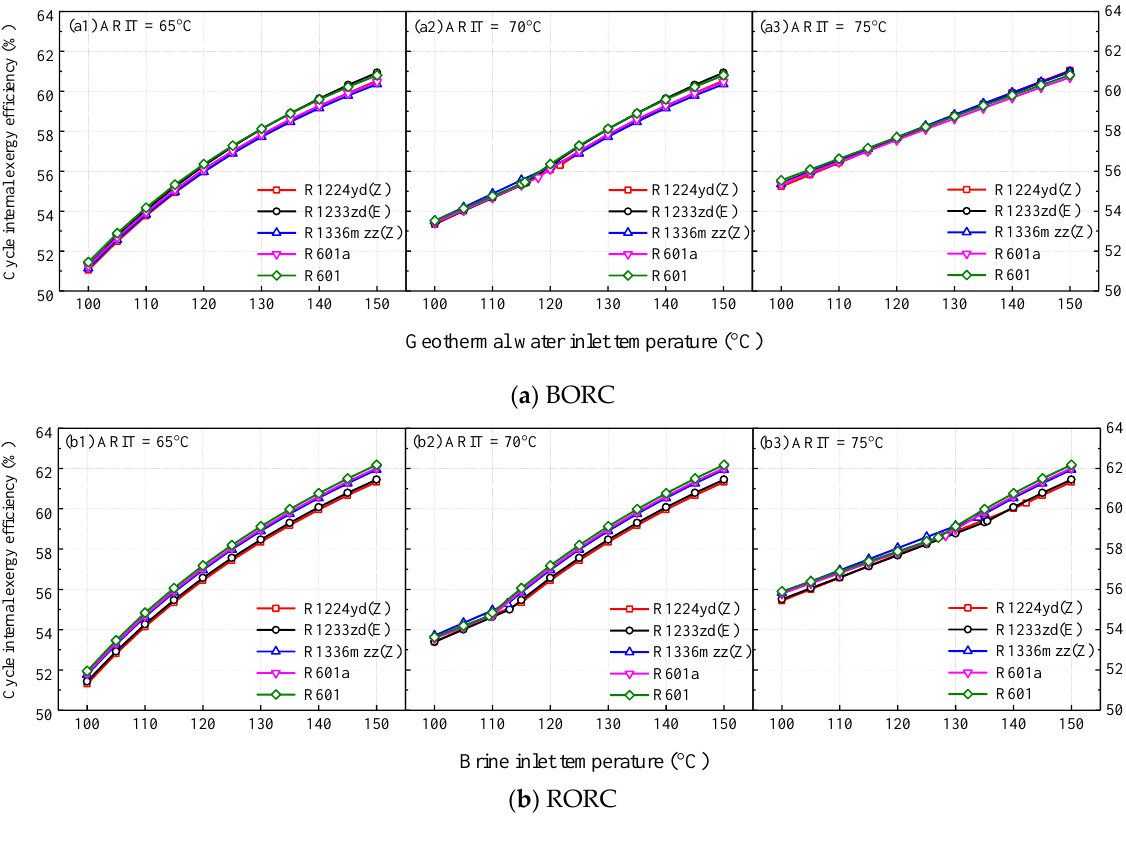
Figure 9. Cycle internal exergy efficiencies for ( a ) ORCs and ( b ) RORCs at the optimal conditions for various BITs and ARITs.